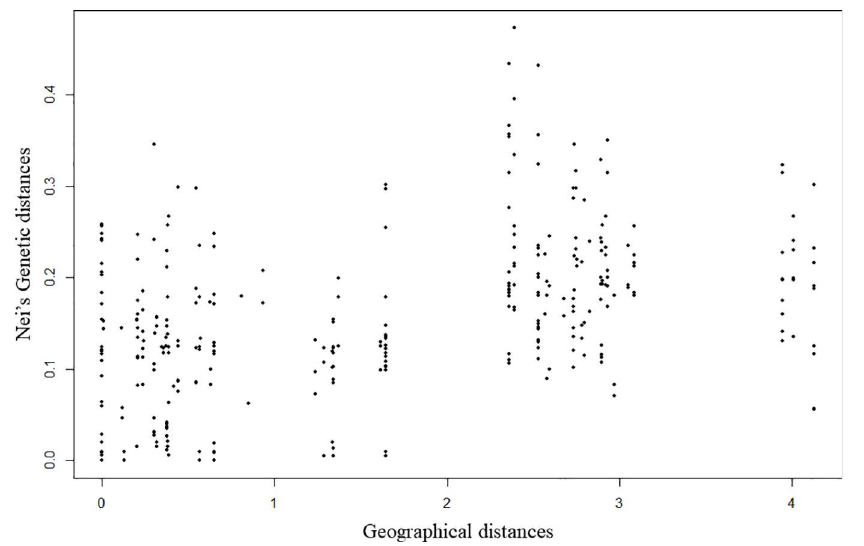
Fig 6. Correlation of individual Nei’s genetic and geographical